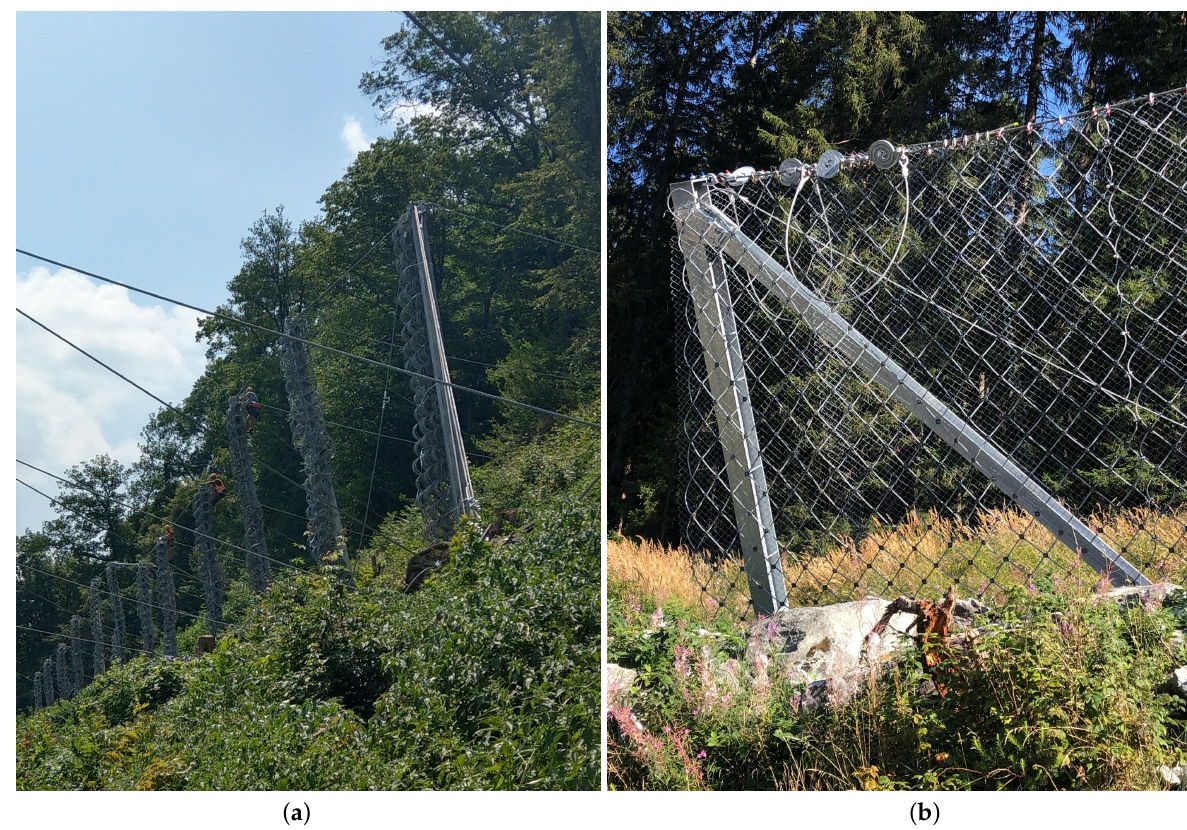
Figure 1. ( a ) Installed posts with pre-installed net panels according to clear and easy to implement mounting instructions; ( b ) modification at the lateral end of a barrier without lateral anchors with a diagonal strut as